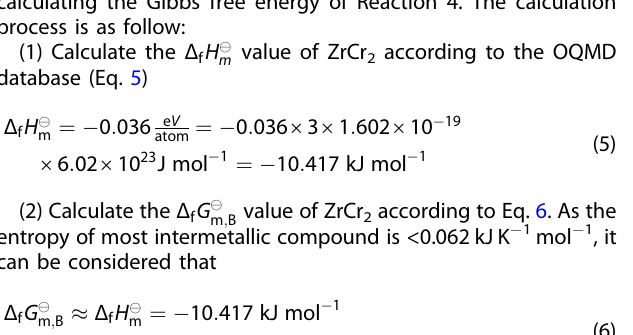
calculating the Gibbs free energy of Reaction 4. The calculation process is as follow: (1) Calculate the Δ f H (cid:2) value of ZrCr 2 according to the OQMD m database (Eq. 5)